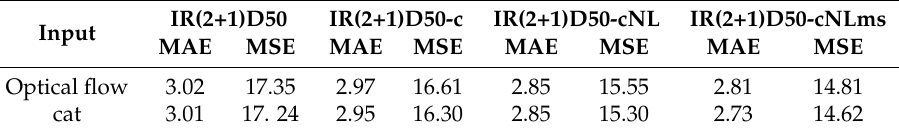
Table 6. Influence of non-local blocks and multi-scale